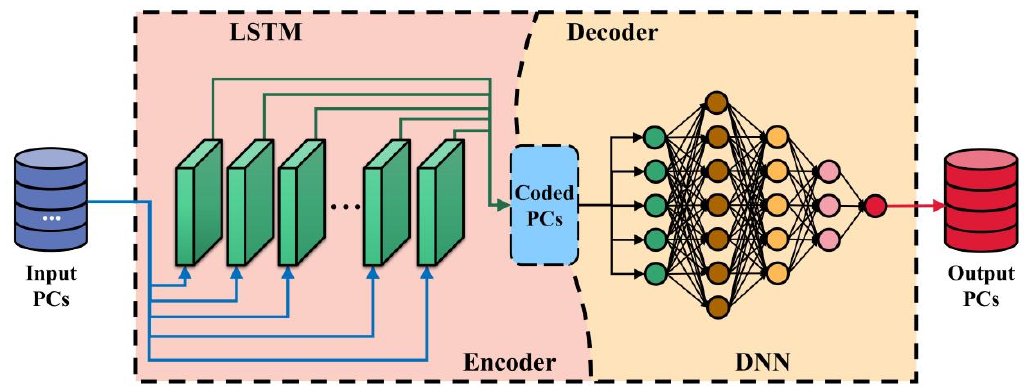
Figure 4. The process of the LSTM–DNN model.